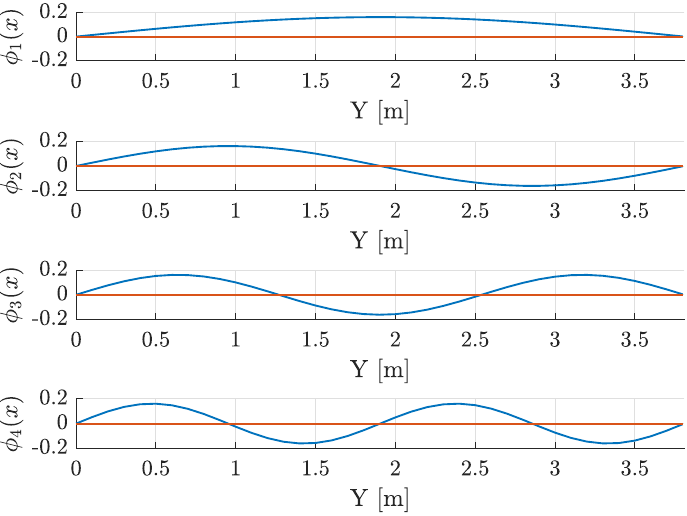
Figure 17. Vibration modes of the Y-rail. From top to bottom: first, second, third and fourth vibration mode.